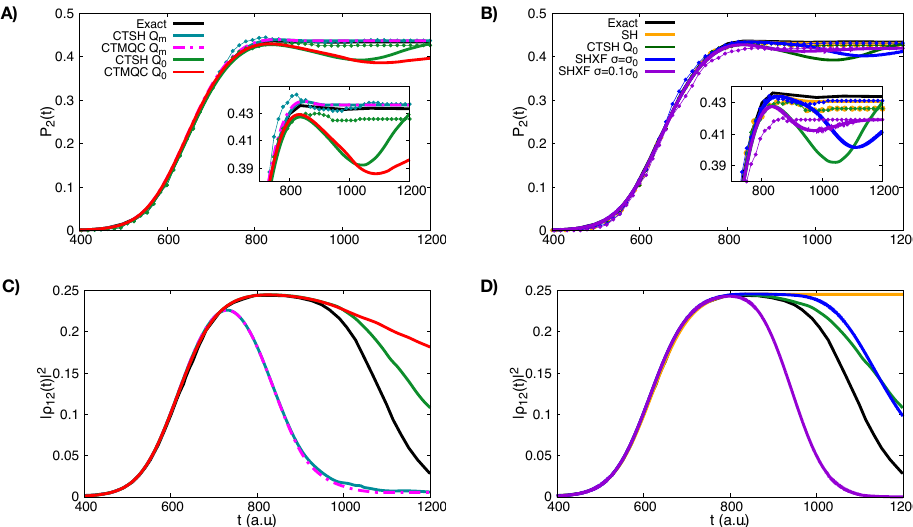
Figure 3. Upper panels: electronic populations ( A , B ), and of the excited state ρ 22 ( t ) (solid) and fraction of trajectories on the excited state Π 2 ( t ) = N 2 ( t ) / N traj (dotted), with N 2 ( t ) being the number of trajectories running on the upper surface at a given time and N traj the total number of trajectories, are plotted for ECR model with k 0 = 30 a.u., as functions of time starting at 400 a.u. which is when the trajectories and the quantum wavepacket approach the NAC region. The label Q m indicates the use of Equation (27), i.e., the modified definition of the quantum momentum, while Q o indicates the use of Equation (22), i.e., the original definition. Lower panels: electronic coherences ( C , D ), | ρ | 2 = ∑ N traj | C α ∗ ( t ) C α ( t ) | 2 / N α traj . The color code is the same as in the upper panels. The coupled- 12 2 1 trajectory results are compared with exact results in the left panels, whereas auxiliary-trajectory results are shown in the right panels. For reference, surface-hopping (SH) results with no decoherence corrections are shown in the right